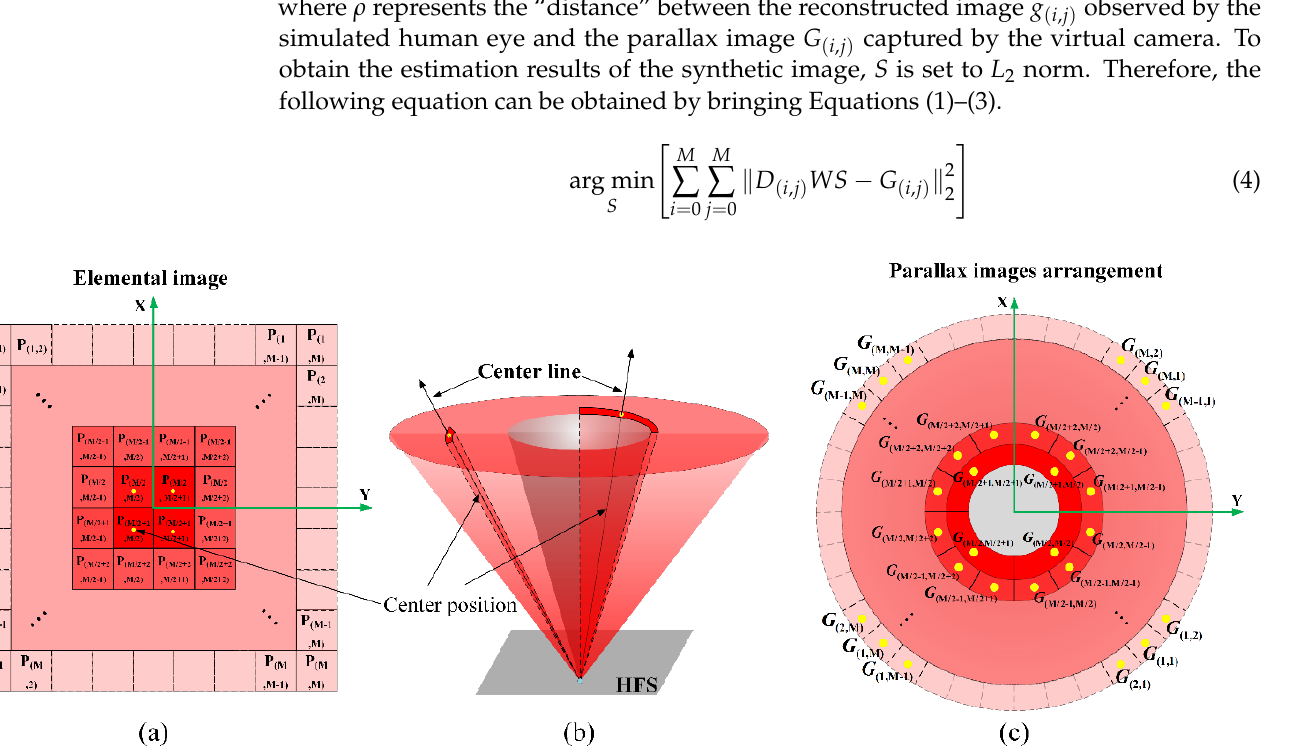
Figure 4. ( a ) Pixels of elemental image displayed on the LCD. ( b ) Center lines of the light rays emitted from HFS. ( c ) The distribution of the parallax images array captured by the virtual camera array.